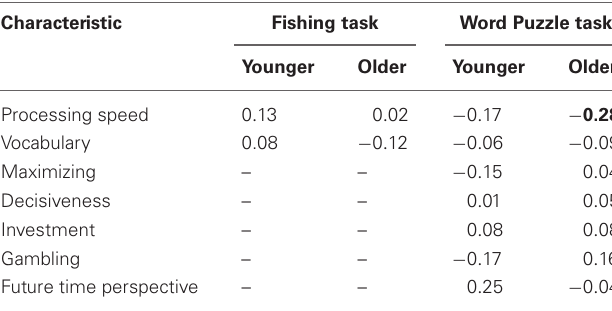
Table 3 | Correlations between giving-up times and individual difference